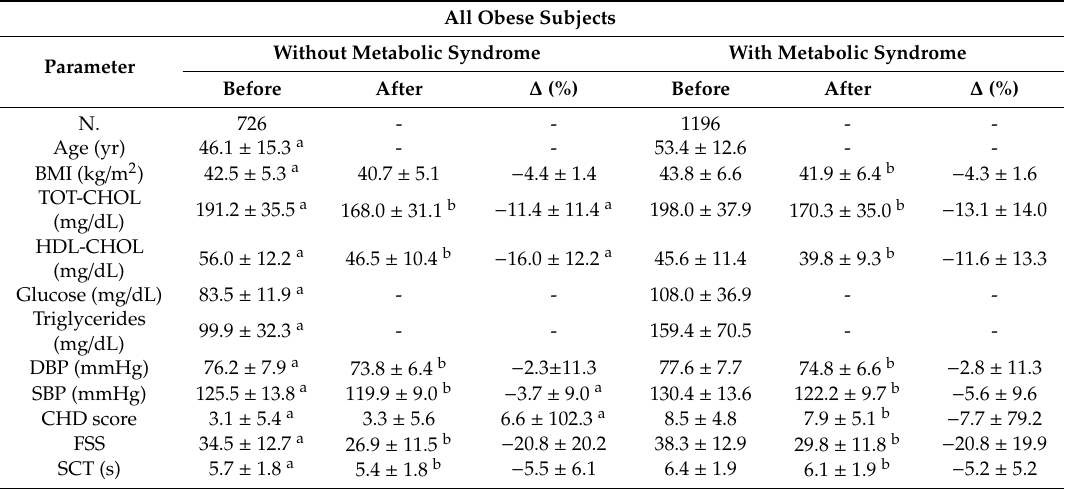
Table 1. Demographic, biochemical, and clinical characteristics of all obese subjects recruited in the study, subdivided into the two groups with or without metabolic syndrome, who underwent the 3-week BWRP. All Obese Subjects Without Metabolic Parameter